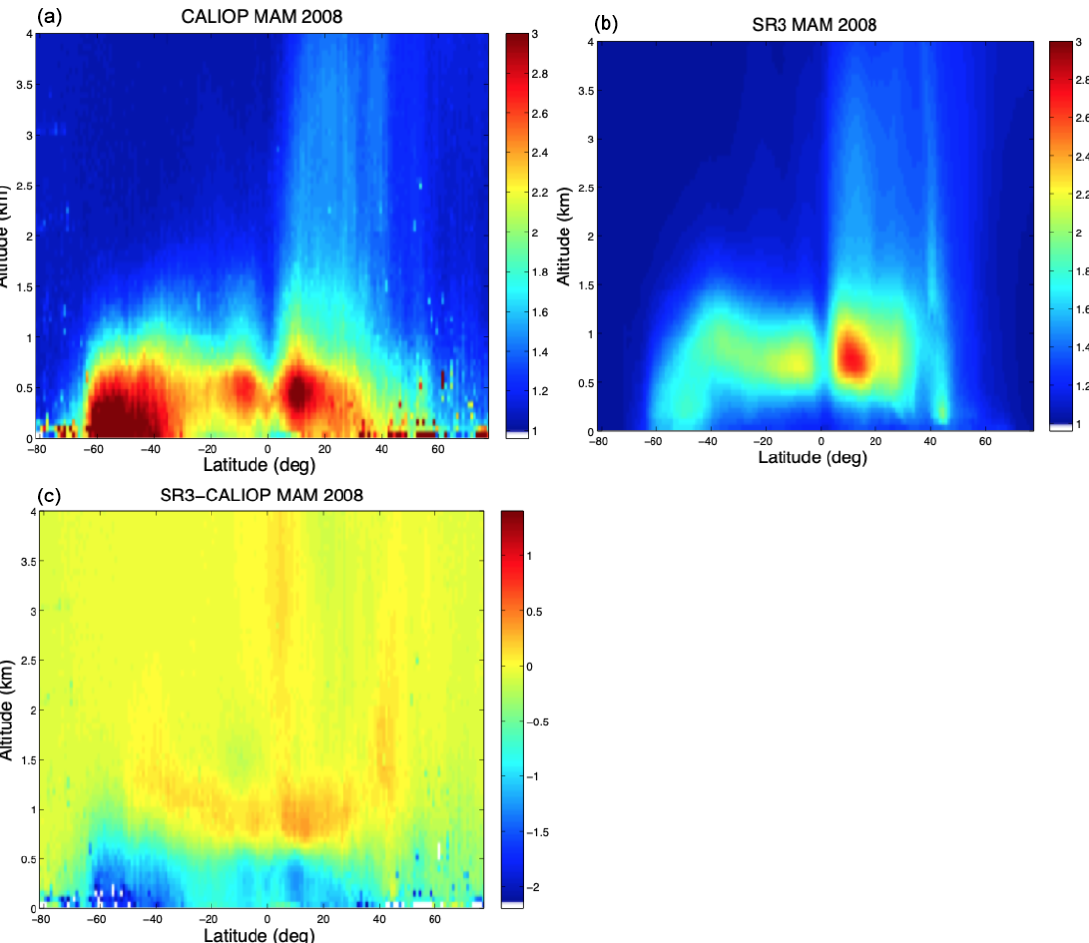
Figure 9. (a) CALIOP SR after data processing (see text for details); (b) model SR_observable; (c) difference between model SR_observable and CALIOP SR. All fields are shown between 0 and 4km and are averaged over all longitudes and time during MAM